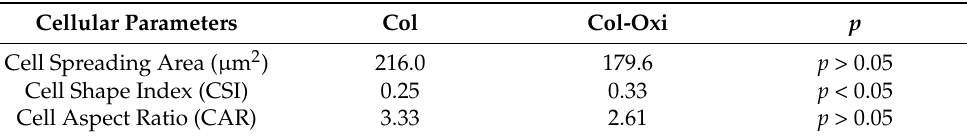
Table 1. Morphometric analysis of ADMSC adhering to native and oxidized collagen, including Cell Spreading Area, Cell Shape Index (CSI), Aspect Ratio (AR), and corresponding p values. Cellular Parameters Col Col-Oxi p Cell Spreading Area ( µ m 2 ) 216.0